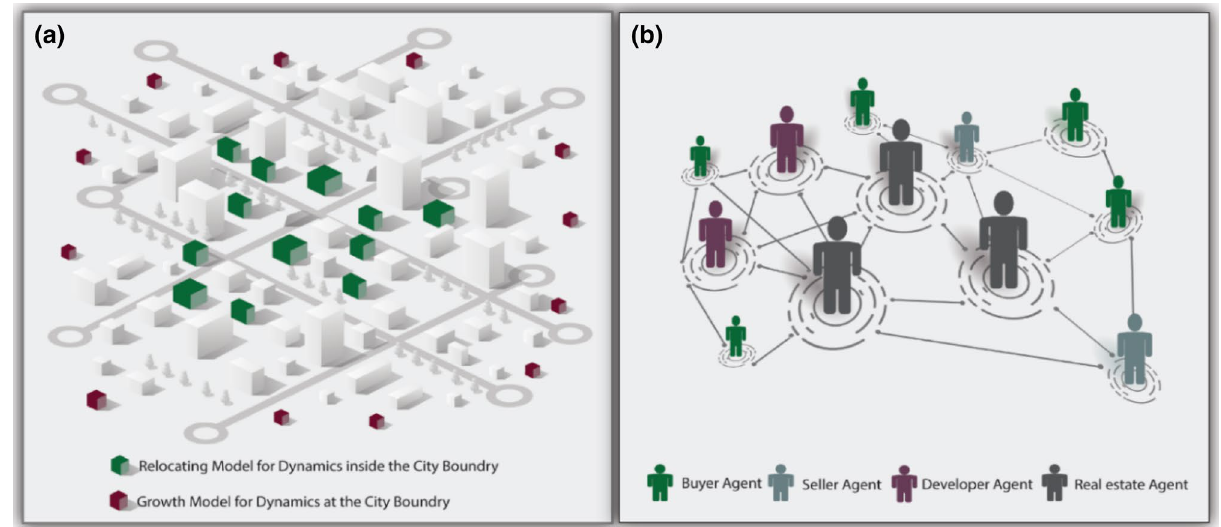
Figure 1. Conceptual model of the proposed behavioral urban growth